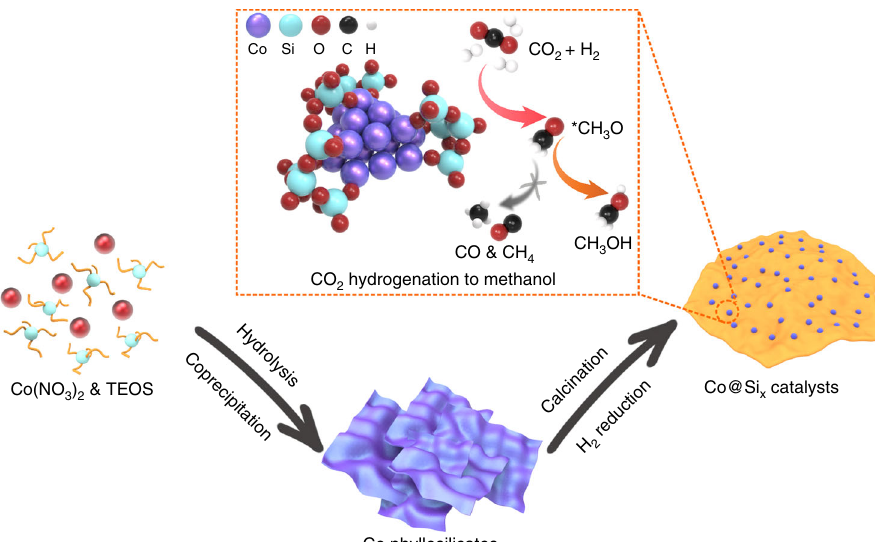
Fig. 1 Synthesis and catalysis strategies of Co@Si x catalysts. The procedures with cobalt phyllosilicates as intermediates for synthesizing Co@Si x . Within the highlighted square, the CO 2 -to-methanol transformation on Co@Si x catalysts.